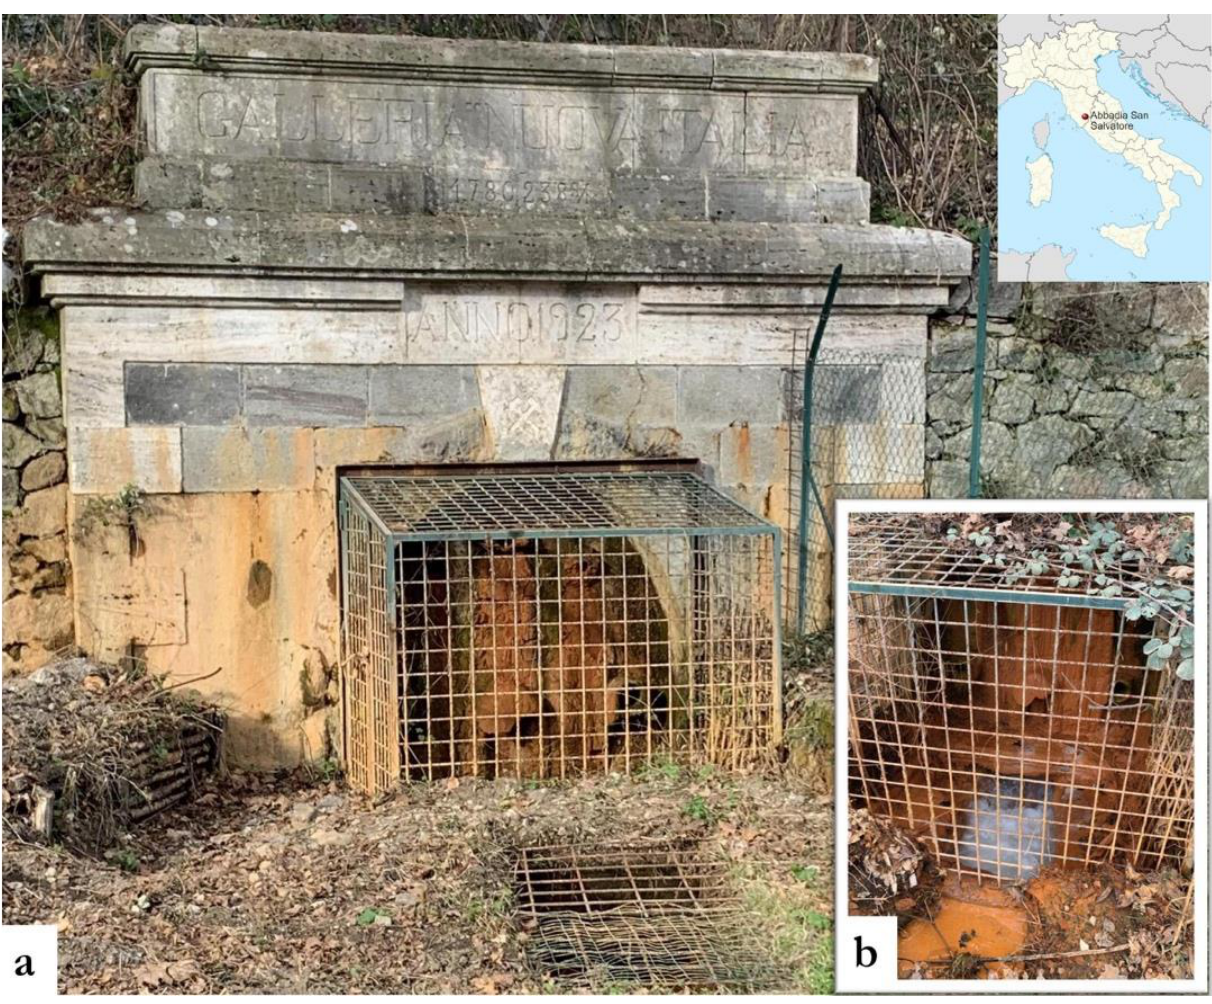
Figure 1. Location of Abbadia San Salvatore: ( a ) Galleria Italia and ( b ) a detail of the water discharge where the reddish-whitish color can be observed.